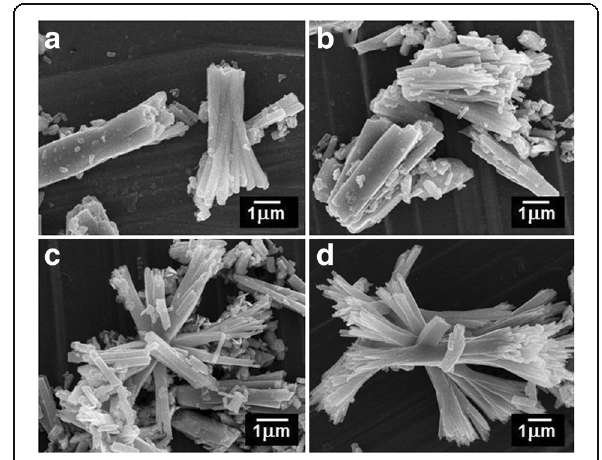
Fig. 2 FE-SEM images of a Sb 2 S 3 , b 0.1 HEC-Sb 2 S 3 , c 0.2 HEC-Sb 2 S 3 , and d 0.3 HEC-Sb 2 S 3